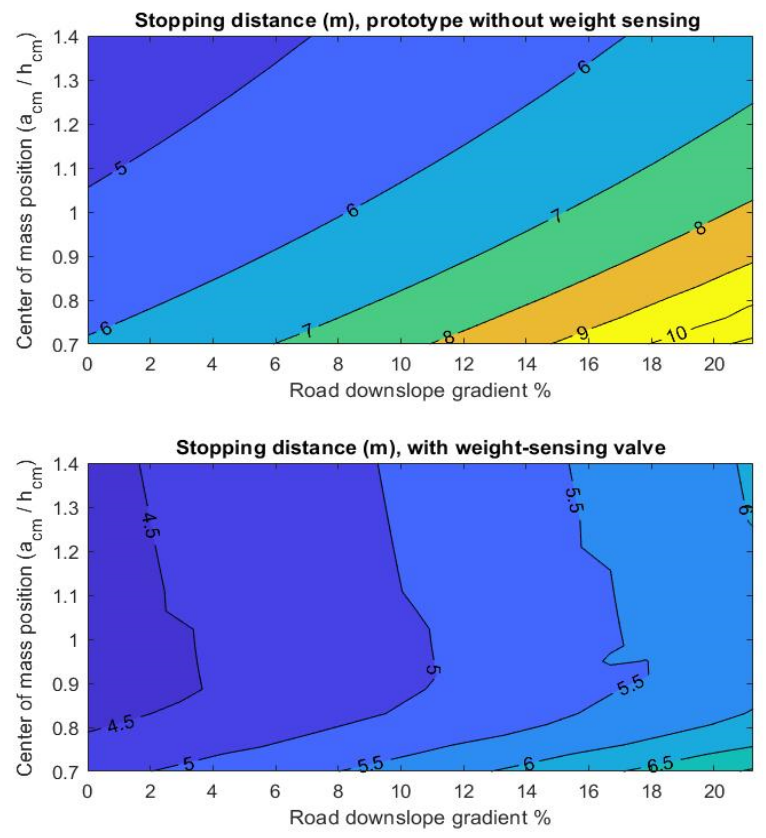
Figure 15. Stopping distances for the prototype proportioning system and an ideal proportioning system with rear tire normal force sensing. For values of a cm / h cm below 0.9, the stopping distance becomes limited by tip-over.